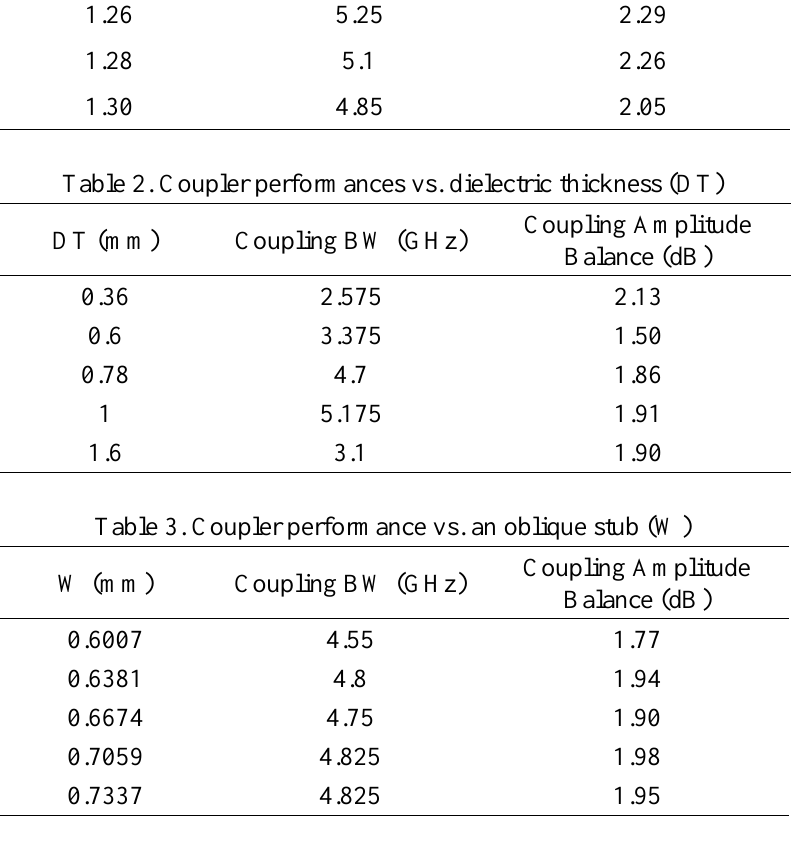
-coupling, S - isolation) 13 14